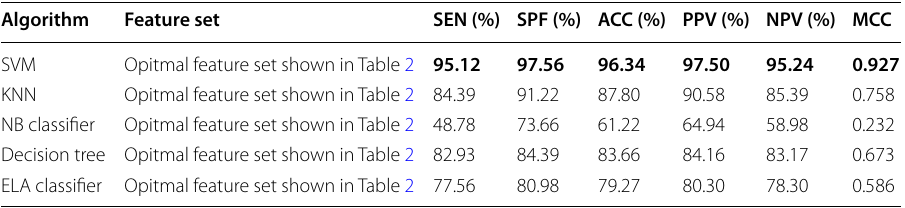
Bold values to highlight the relevant numbers Table 8 Performance indexes for the optimal subset and for each classification algorithm using 2-fold style under fast walking speed Algorithm